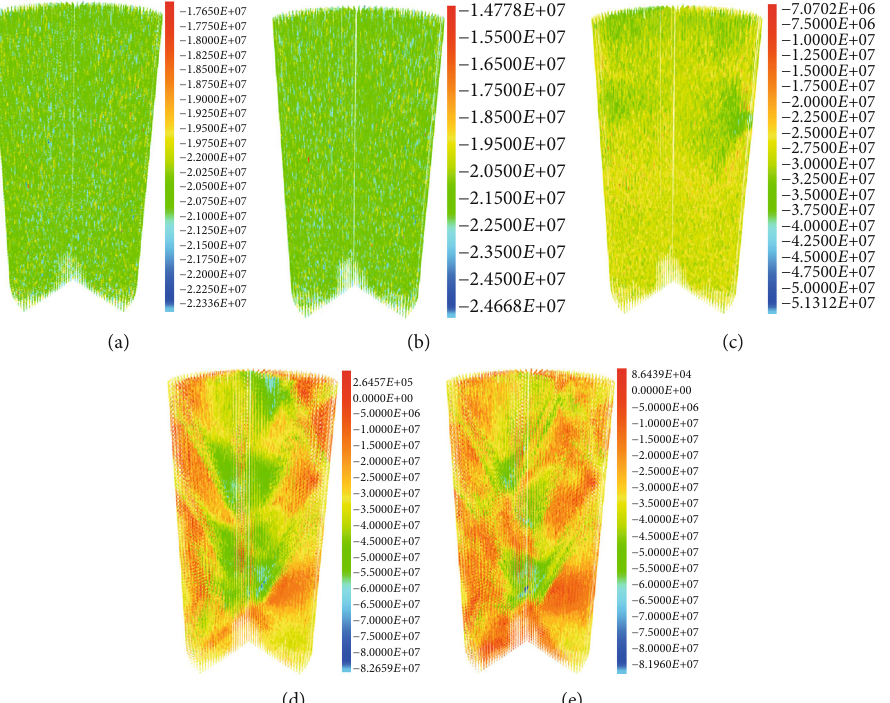
Figure 12: Evolution of maximum stress tensor (Pa) for simulated HM coupled test: (a) initial compressed stage, (b) elastic stage, (c) peak stress point, (d) stress drop stage, and (e) residual stage.